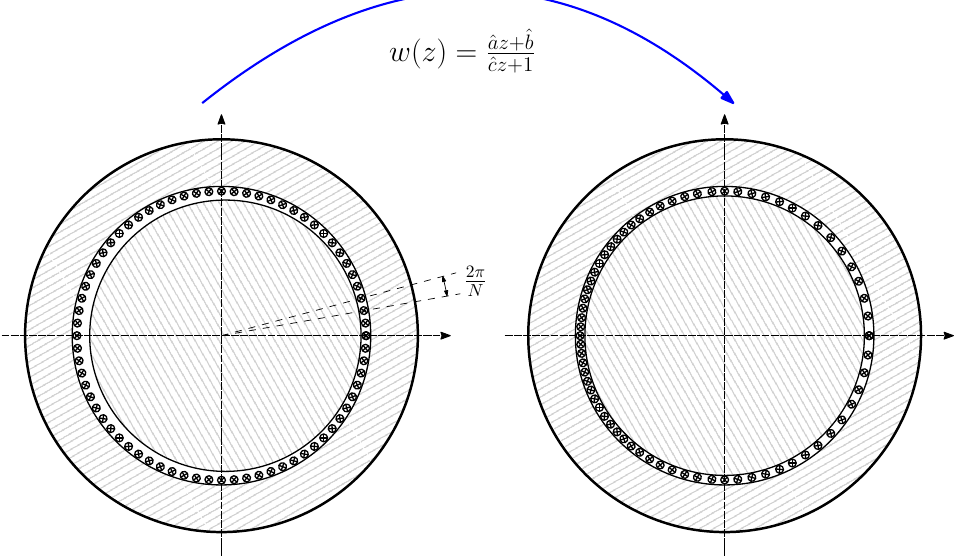
Figure 12. Moebius transformation of the elementary conductors placed in the air gap that constitute the primitive spatial network of the IM, given in Figure 6. The original set of N equally spaced elementary conductors placed in the non-uniform air gap of the eccentric IM ( left ), becomes a set of N elementary conductors with non-uniform spacing in the smooth air gap of the transformed IM ( right